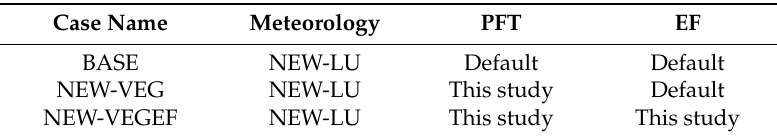
Table 2. Sensitivity simulation cases for BVOC emissions and ambient concentrations and database used in each case.